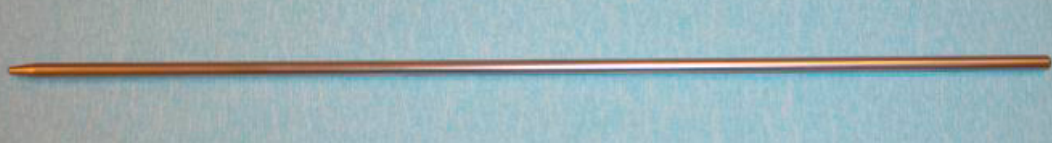
Figure 5. Magnetic retriever. Figure 5. Magnetic